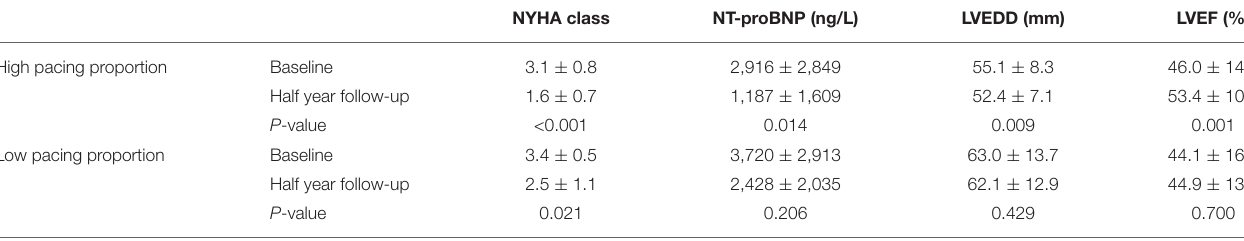
TABLE 2 | Clinical outcomes and echocardiographic changes of patients under high and low pacing proportion.